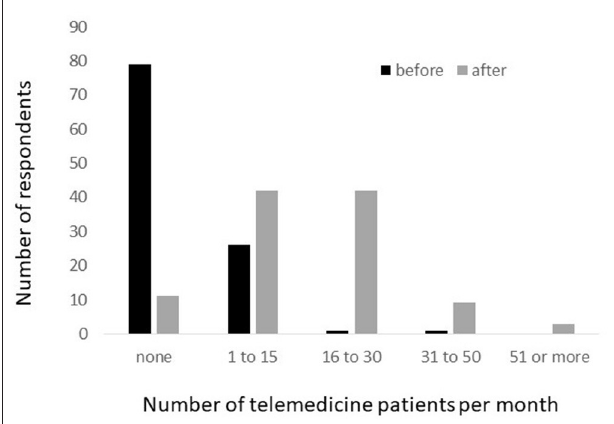
FIGURE 1 | Number of patients with IMDs seen per month via telemedicine, before and after the onset of the COVID-19 pandemic.